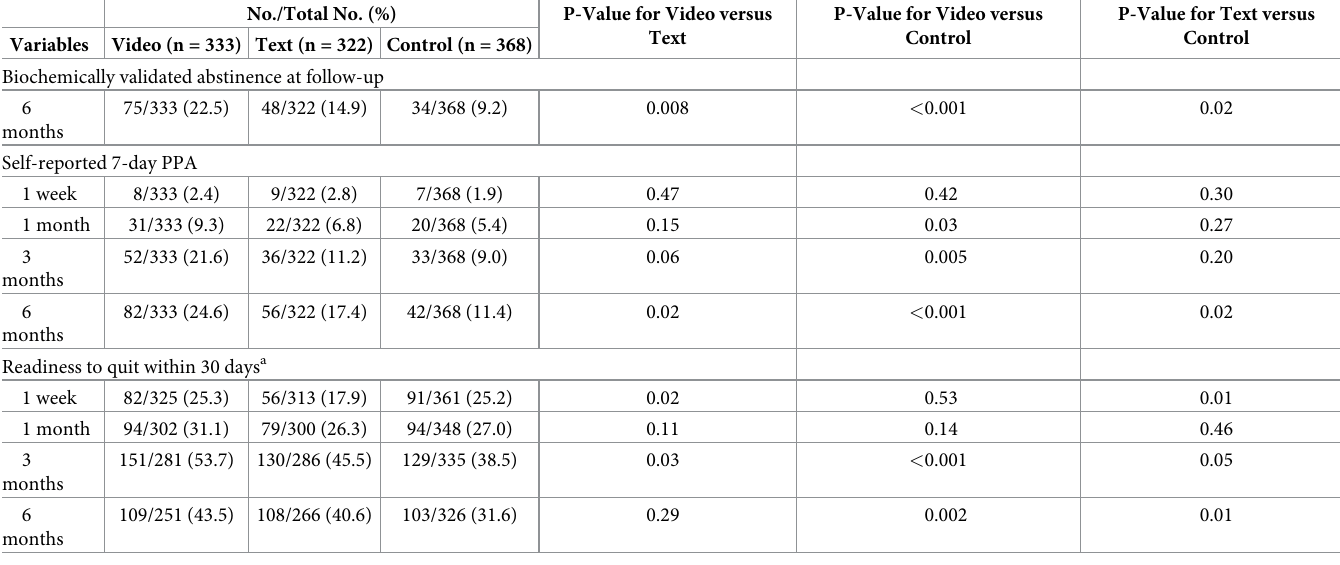
P-Value for Video versus P-Value for Text versus Text Control